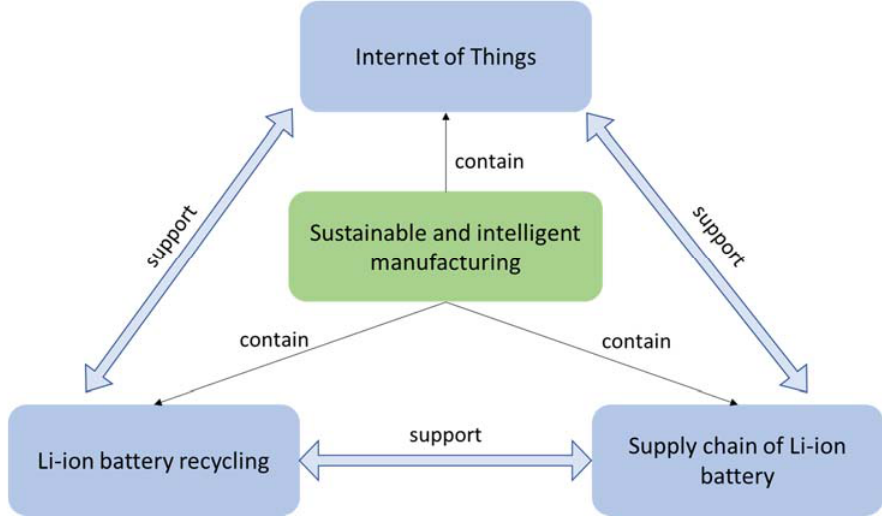
Figure 8. Proposed paradigm for IoT enhanced direct recycling of LIBs application [109].